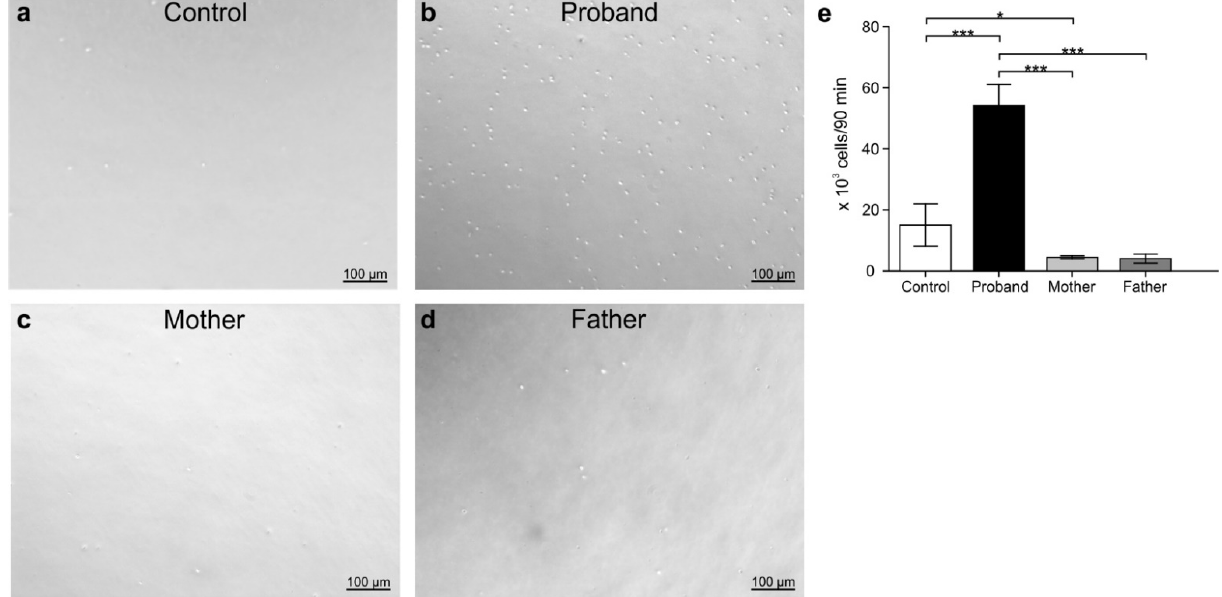
Figure 7. Transmigration of peripheral blood mononuclear cells assay. Peripheral blood mononuclear cells (PBMC) were isolated from different subjects: control ( a ), proband ( b ), mother ( c ), and father ( d ). Subsequently, the cells (120,000) were added to the surface of a transwell filter (Ø = 3 µm) and stimulated with 1 µM of the 10 pg/mL of chemokine cocktail (Bio-Plex Human Chemokine Assays, BioRad). Afterwards, the cells were incubated at 37 °C for 90 min and subsequently the transmigrated cells were counted, and the results compared using t -test ( e ). * p < 0.05 ** p ≤ 0.01, *** p < 0.001 ( n = 3).